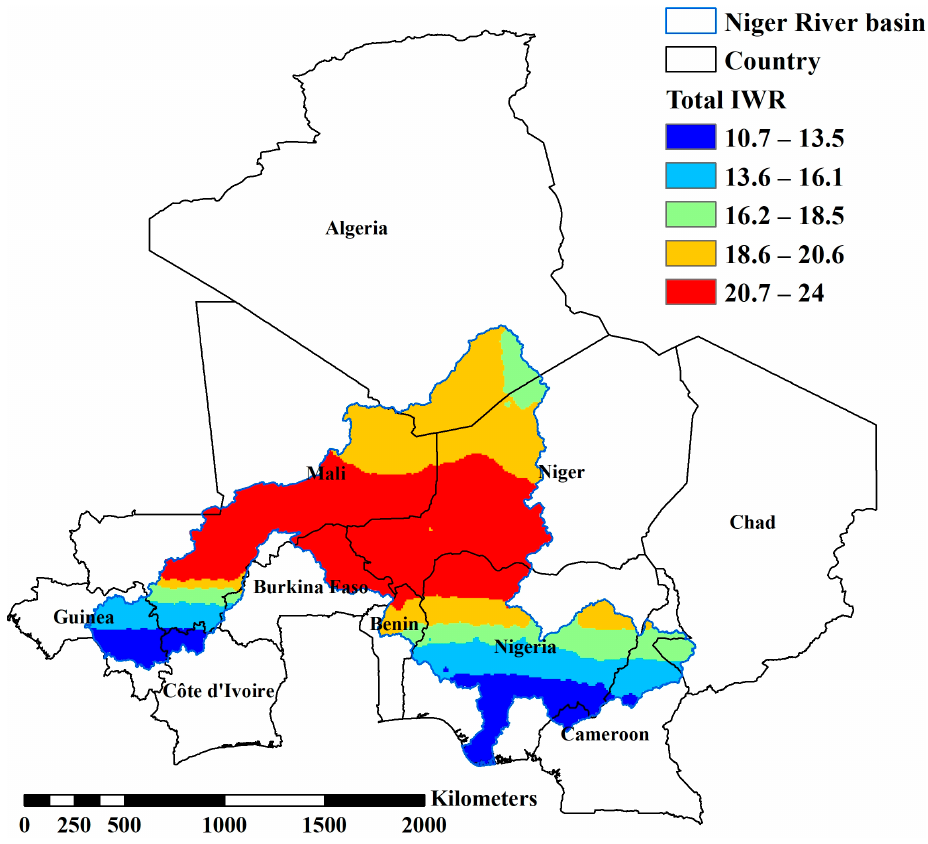
Figure 4. IRW under CSIRO. It shows the global irrigation water requirements in different countries in the basin under the RCP 8.5.